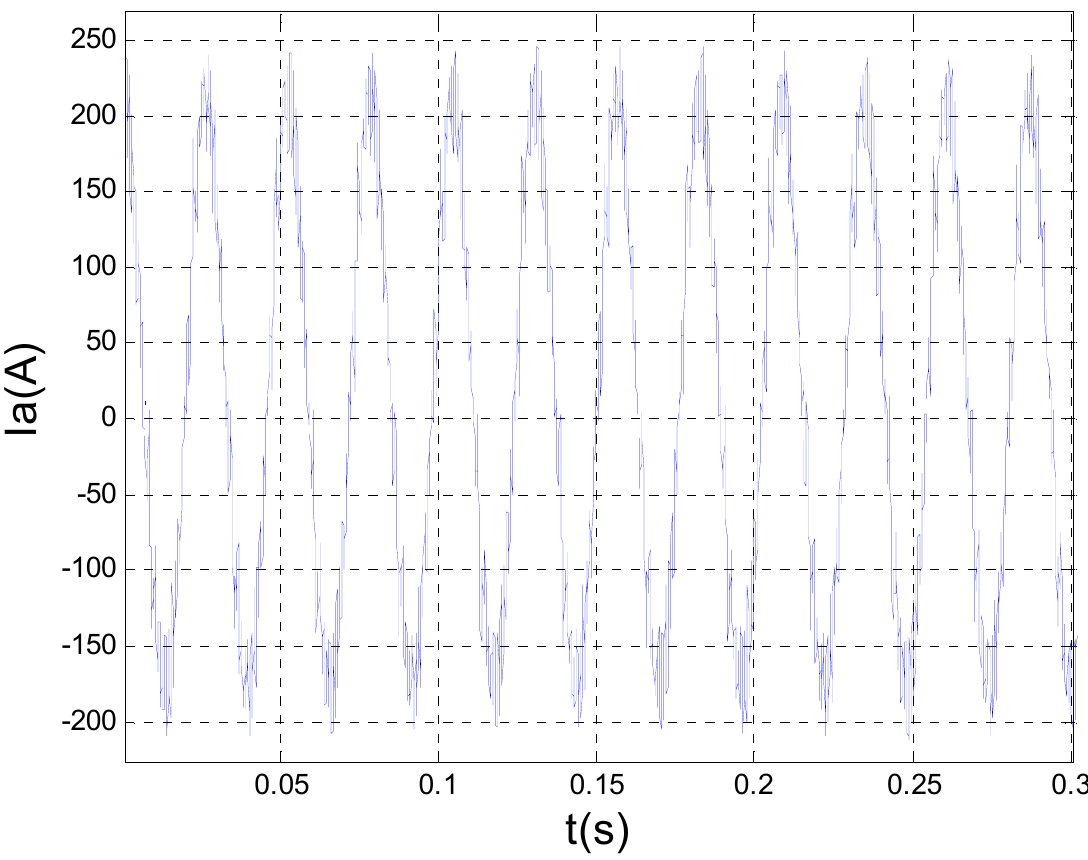
points at different temperatures.